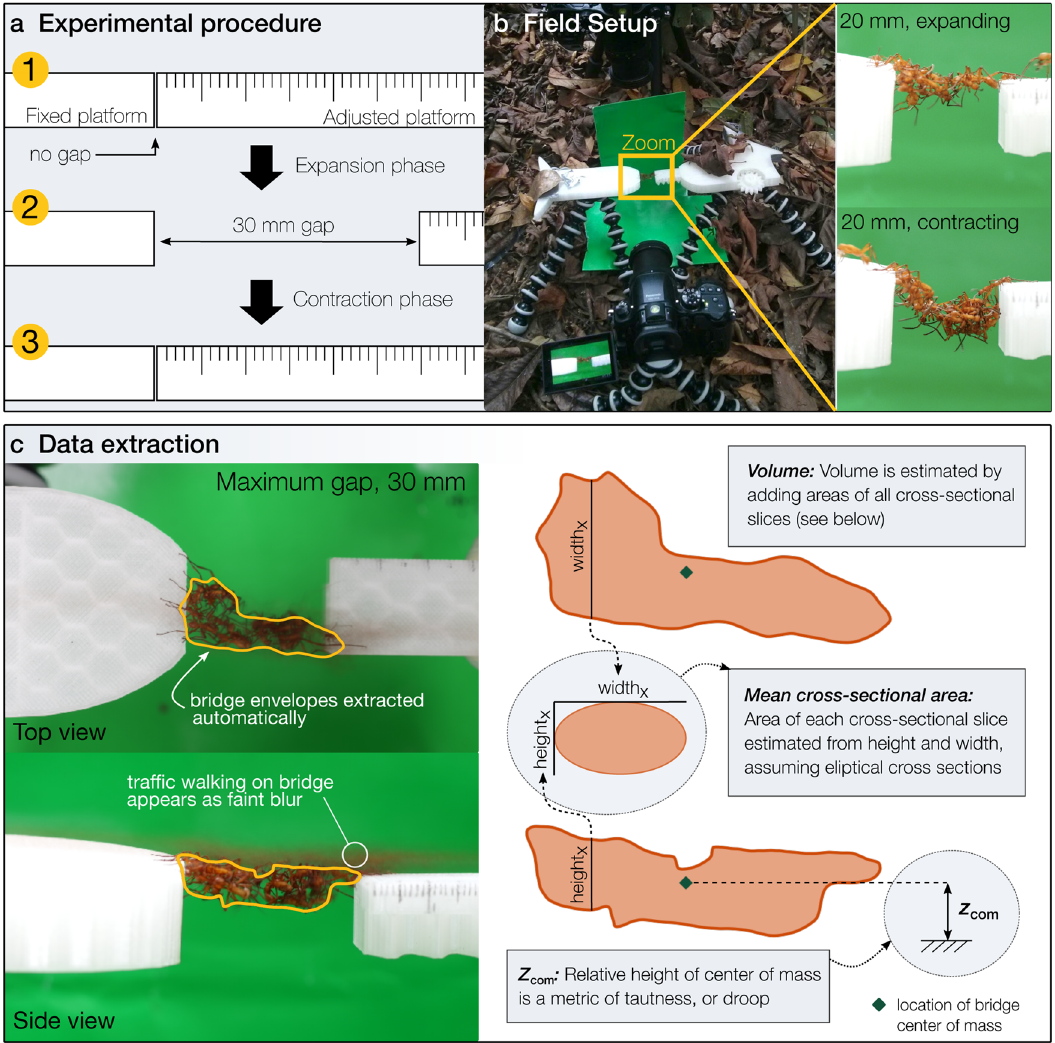
Fig. 1 Experimental procedure and data extraction summary. Experiments were conducted on robust E. hamatum foraging trails, which were moved onto the experimental apparatus while it was closed. a Experimental procedure: The size of the gap was increased by 1 mm every 30 s until the gap reached 30 mm (expansion phase), then decreased at the same rate till no gap remained (the contraction phase). b Field setup: Experiments were recorded from both the side and the top, examples of bridges during each phase of the same trial are shown. c Data extraction: Example images and silhouettes from the maximum size bridge (30 mm) of the same trial as the images of 20 mm bridges shown in panel a. The envelopes of the bridges were extracted at a temporal resolution of 1 s; for each focal second, image frames were averaged over 10 s to remove ants walking on the bridge from the extracted envelopes. Envelopes were automatically extracted using hue-saturation-value (HSV) thresholding, with thresholds checked independently for each trial due to lighting differences. Locations of fi xed points on the platform were used to re-scale and combine data from the side and top views into a single coordinate system in which 100 pixels = 1 cm. Estimates of bridge volume, mean cross-sectional area, and relative height of the center of mass were recorded from the extracted envelopes as shown. See Methods: Data extraction and Supplementary Note 1 for additional details of the data extraction process, including additional bridge